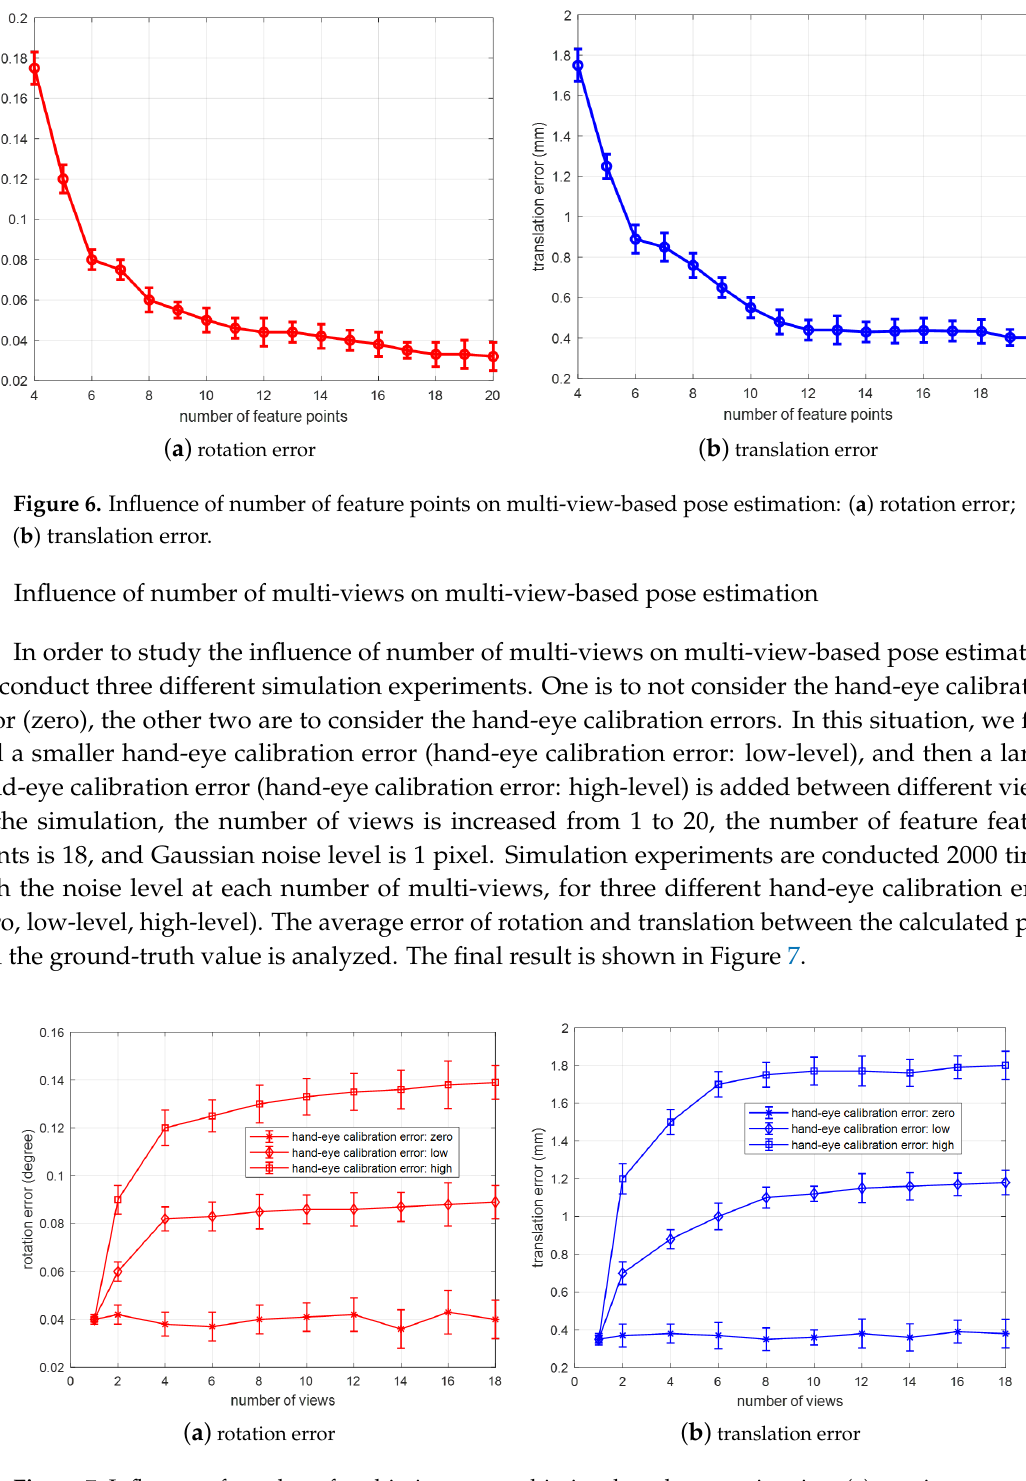
Figure 7. Influence of number of multi-views on multi-view-based pose estimation: ( a ) rotation error; ( b ) translation